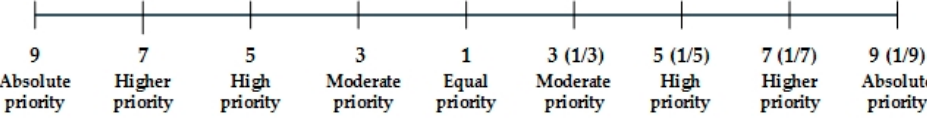
Figure 3. An example of a Saaty scale for defining priorities.